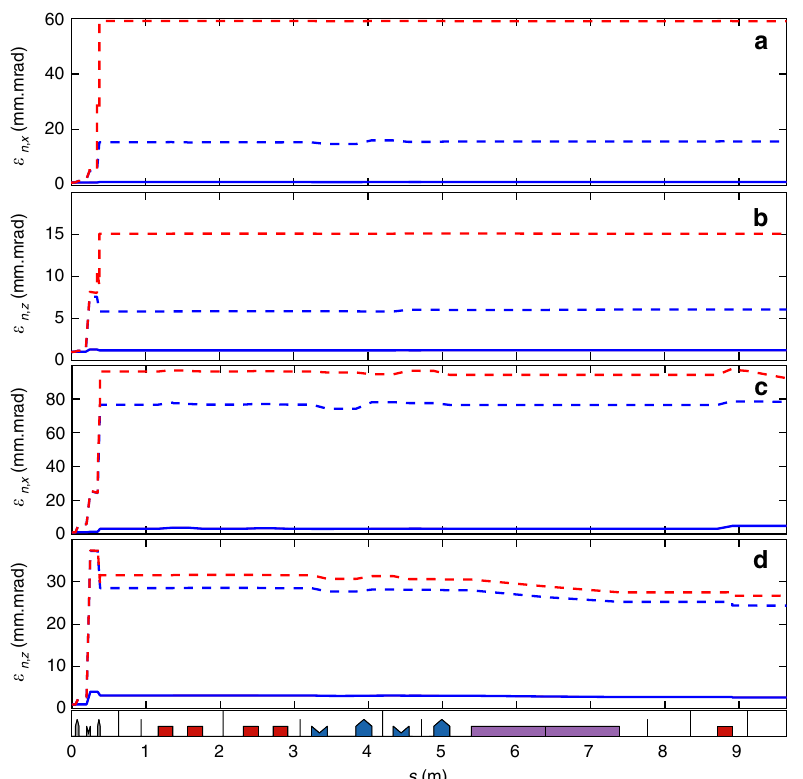
Fig. 8 Evolution of the normalised emittance along the transport line. a Horizontal and b vertical emittance for a ±1 MeV slice and for a ±5 MeV slice c , d without (blue) and with (red) magnetic defects for a reference beam of 1 mrad divergence (solid lines) and using measured divergences from Fig. 2a (dashed